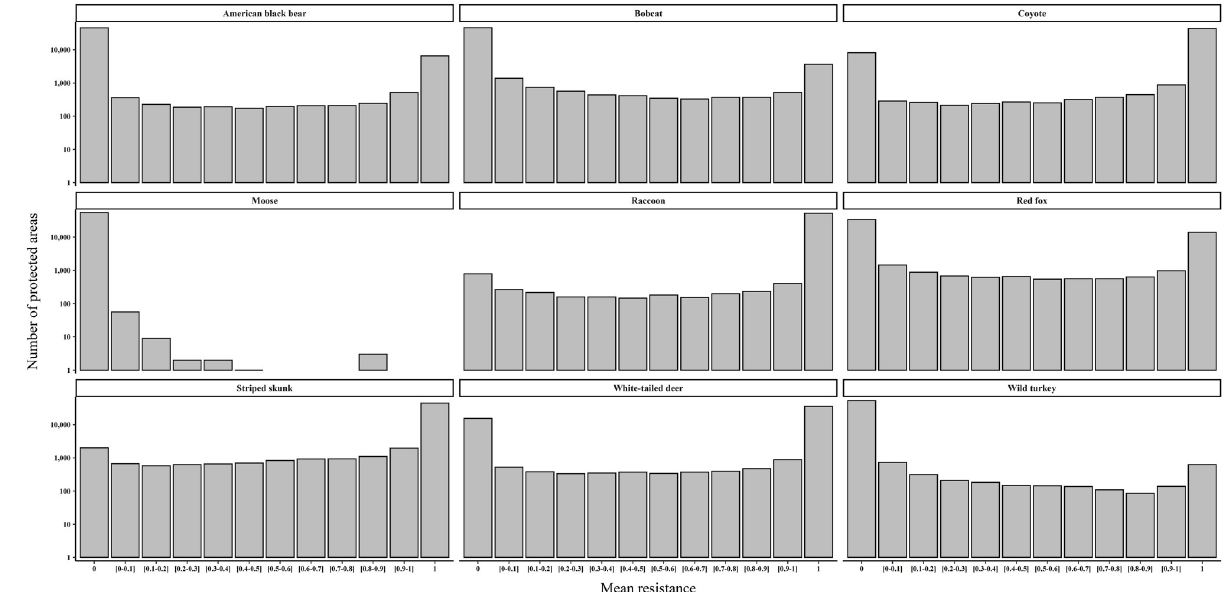
Fig 4. Focal species resistance within New England’s protected areas. Mean resistance indicates the proportion of cells in a protected parcel that are resistant for a given species. Graphs display trends in species mean resistance within individual parcels. Note the logarithmic scale of the y-axes.